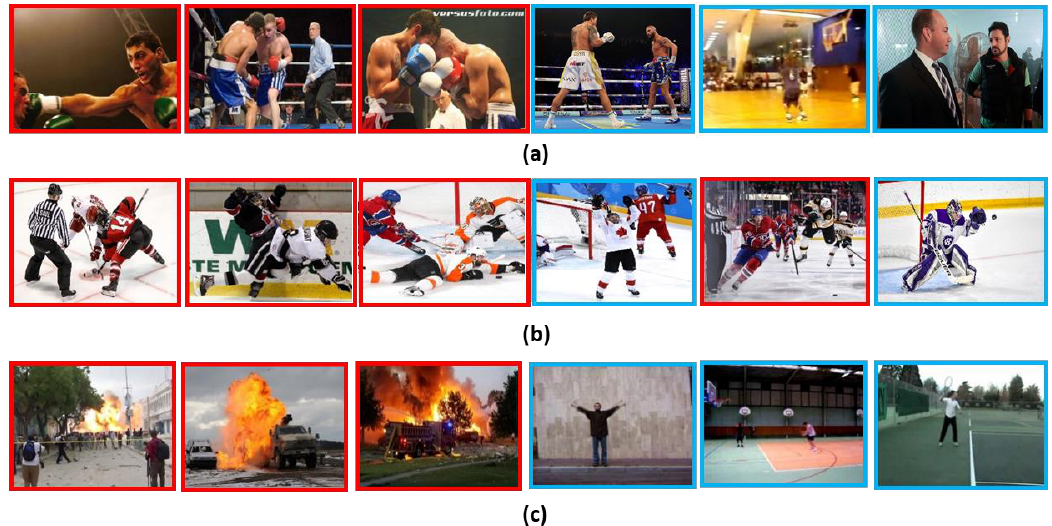
Figure 5. Sample frames from the datasets used for evaluation. In each row, the first three samples are from the violent class and the last three samples are from the non-violent class. ( a ) Violence in Movies, ( b ) Hockey Fights, and ( c ) Violence Scenes Detection datasets. The frames in red and blue are detected as violent and non-violent by the proposed method, respectively.